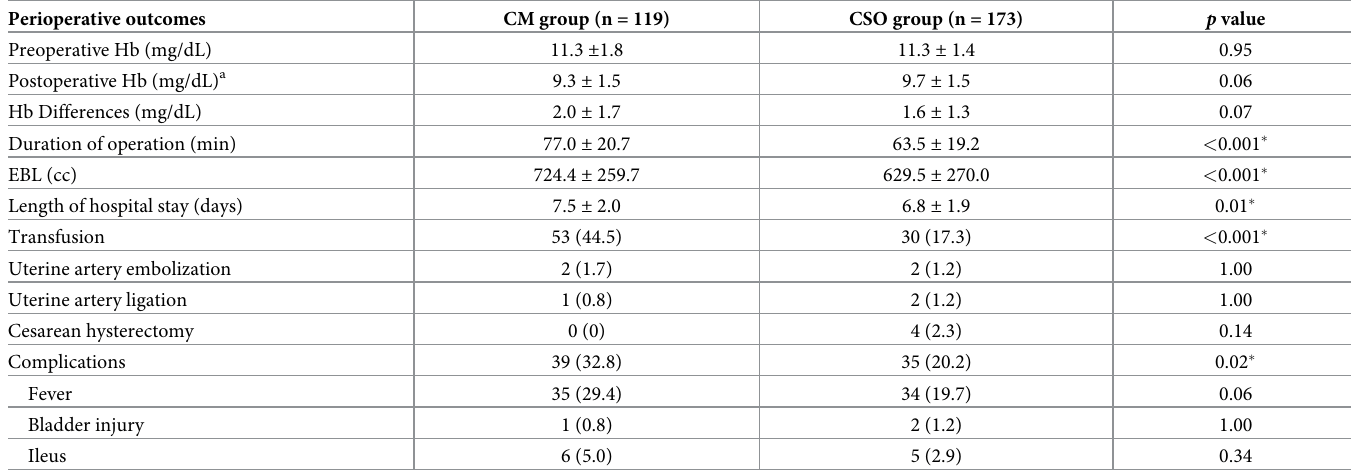
outcomes except for the duration of operation (single, 72.6 min vs multiple, 86.3 min, p = 0.01). There were no differences in Hb level, EBL, or transfusion rate between the two groups beyond the usual expectations (Hb difference, single, 1.9 mg/dL vs multiple, 2.2 mg/dL, p = 0.45; EBL, single, 706.2 cc vs multiple, 763.2 cc, p = 0.16; transfusion rate, single, 40.7% vs multiple, 52.6%, p = 0.22). In addition, there was no difference in the incidence of intra-or postoperative complications between the two groups (fever, single 29.6% vs multiple 29.0%, Table 3. Operative outcomes (n =